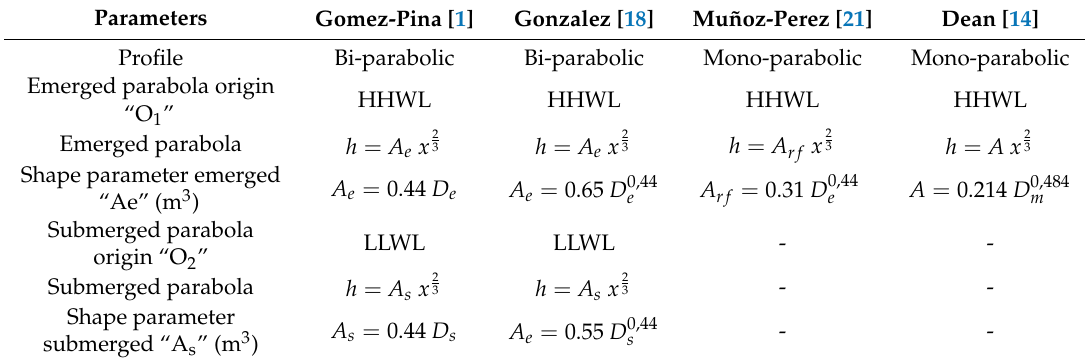
Table 1. Formulation used for the di ff erent design parameters of the models proposed by Dean